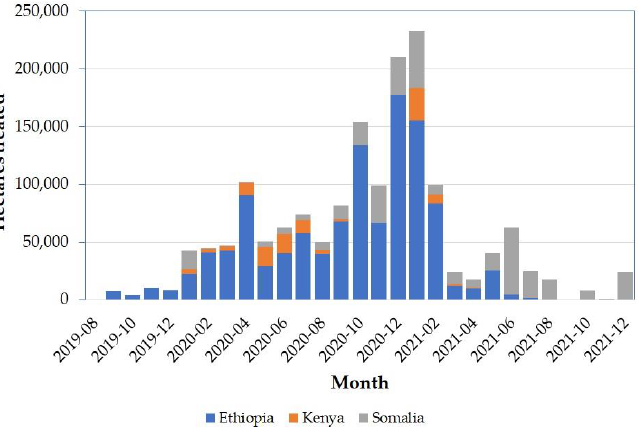
Figure 1. Monthly surface area treated (ha) from August 2019 to December 2021. Data are from the FAO Locust Hub [22].